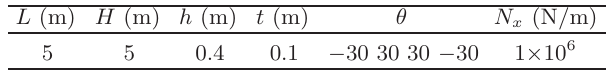
Table 1. Geometrical properties of laminated composite plate.